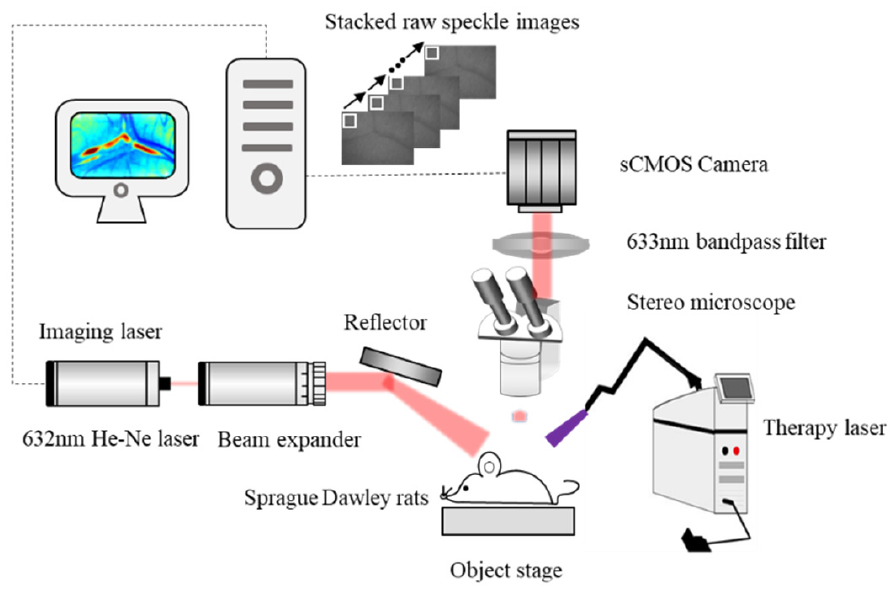
Figure 2. Laser speckle contrast imaging based blood-flow monitoring system during transient laser irradiation.